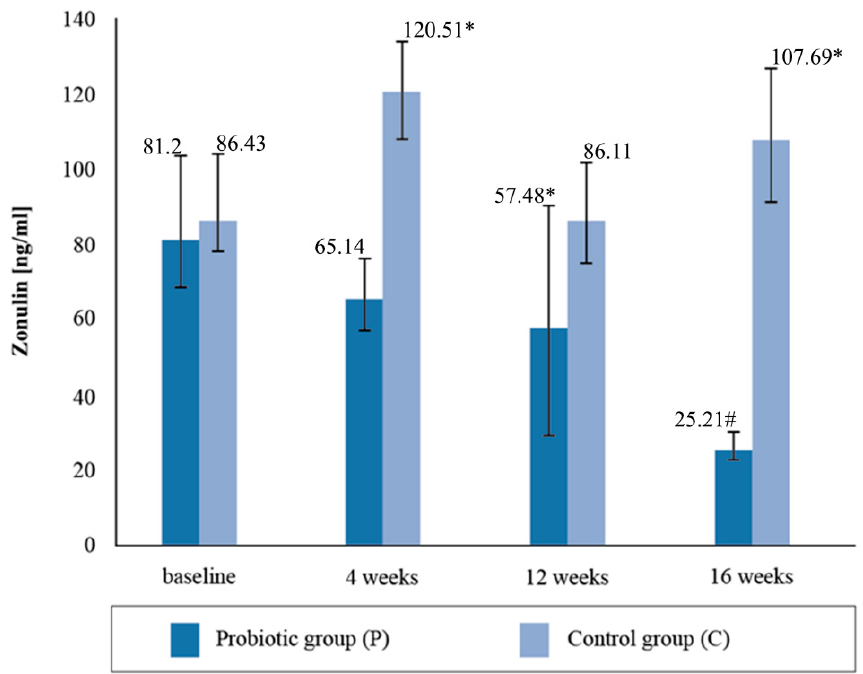
Figure 2. Concentration of zonulin in stool at follow-up measurements during supplementation intervention. * Statistically significant intergroup differences ( p < 0.05); # statistically significant differences compared with the initial value ( p < 0.05).